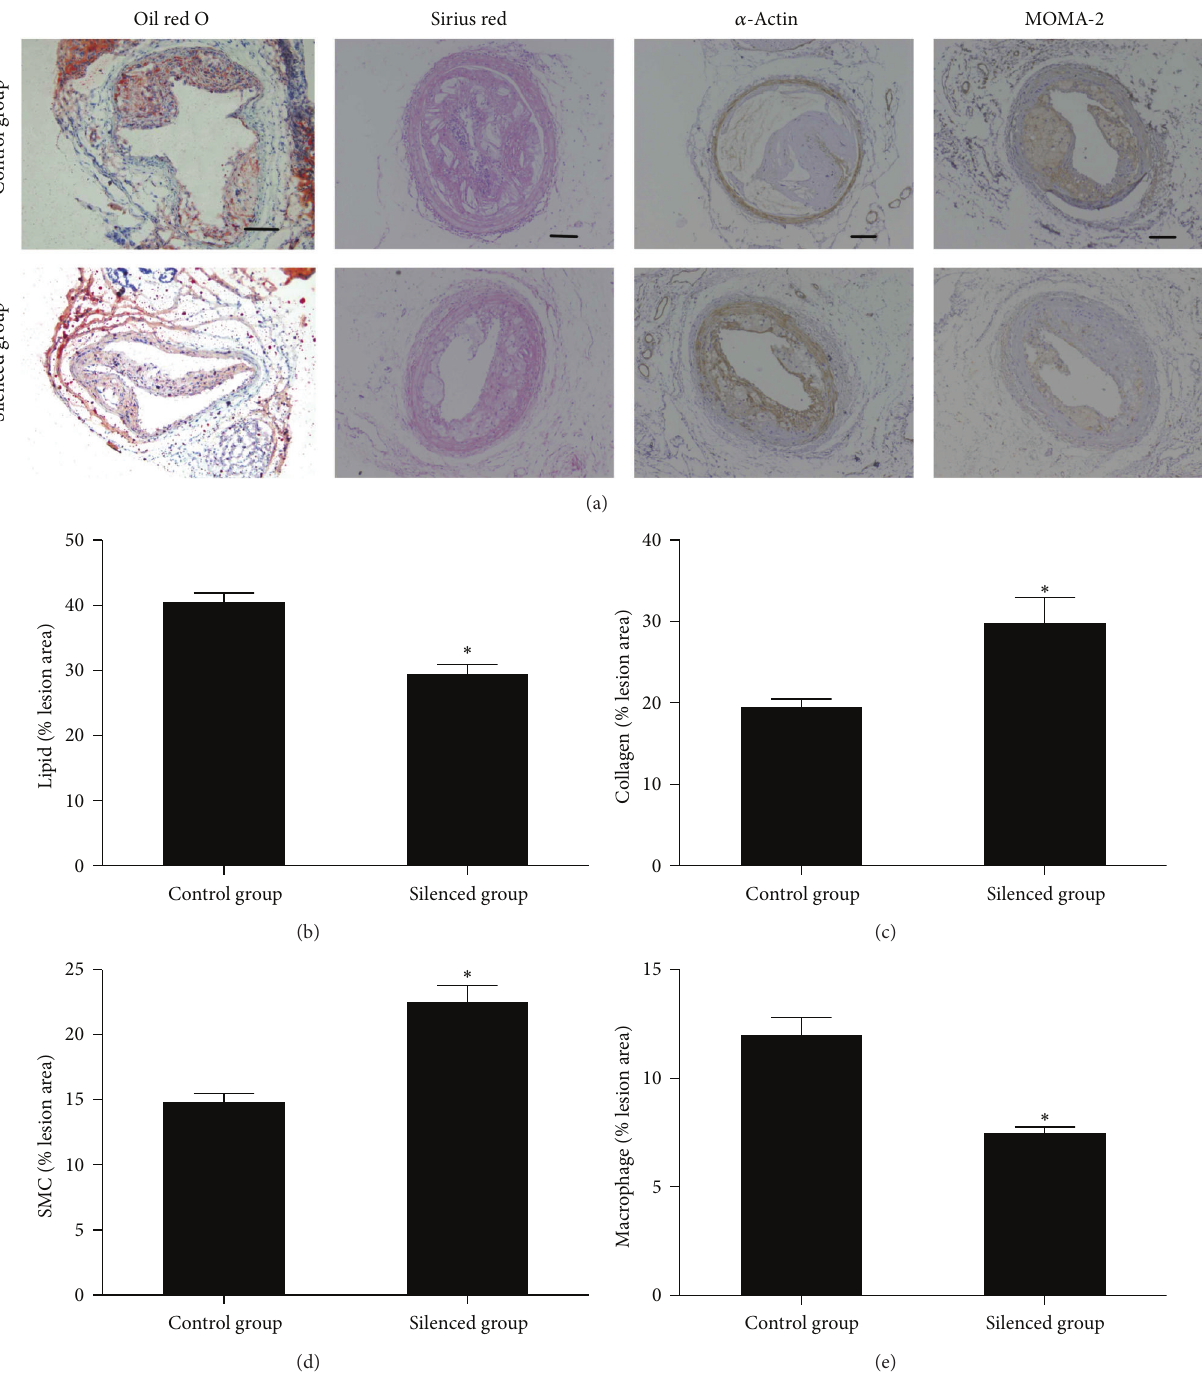
Figure 3: CHI3L1 gene silencing influenced plaque composition and stability. (a) Cross-sections of mice carotid arteries in the control group andsilencedgroupwerestainedforlipids(oilredO),collagen(Siriusred),SMCs( 𝛼 -actin),andmacrophages(MOMA-2).Therelativecontent of lipids (b), collagen (c), SMCs (d), and macrophages (e) in the plaque tissues. The relative contents of lipids and macrophages in plaque tissues were significantly lower in silenced group than in control group. However, the relative collagen and SMCs contents in plaque tissues were increased in silenced group than in control group. ∗ 𝑃 < 0.05 versus control